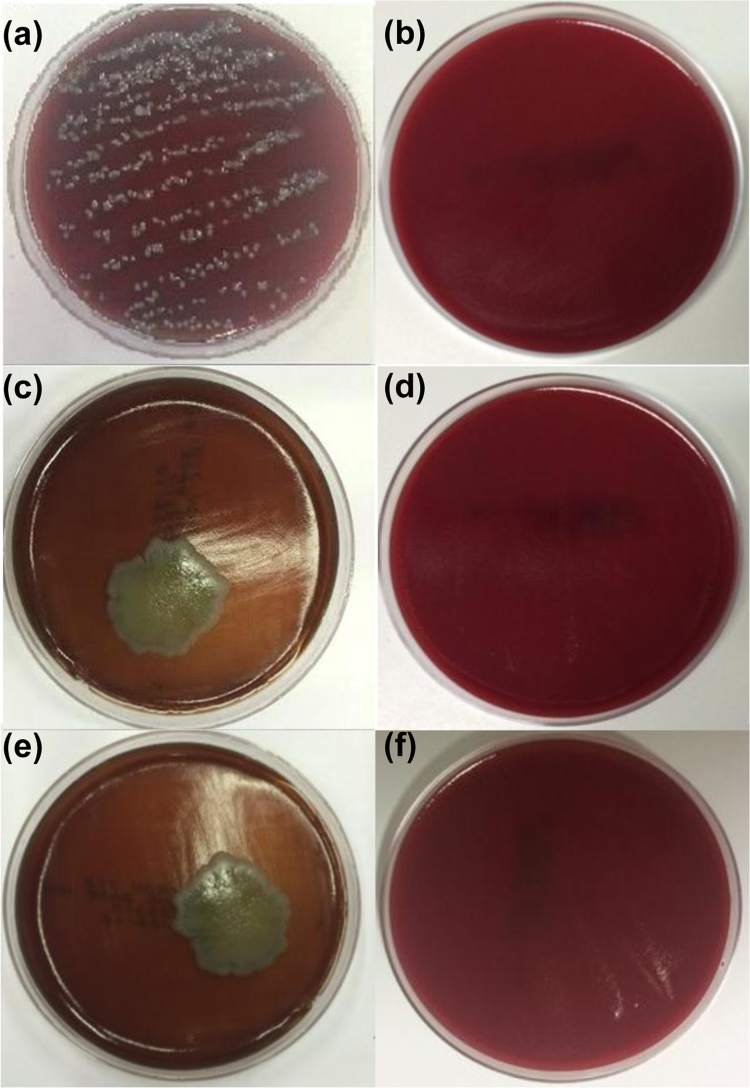
Inoculation of the non-sterile LNC 1 (a), LNC 2(c) and LNC 3 (e) and sterile formulations LNCS 1(b), LNCS 2 (d) and LNCS 3 (f) in a blood agar plate during 48 h at 37 ± 1 °C.